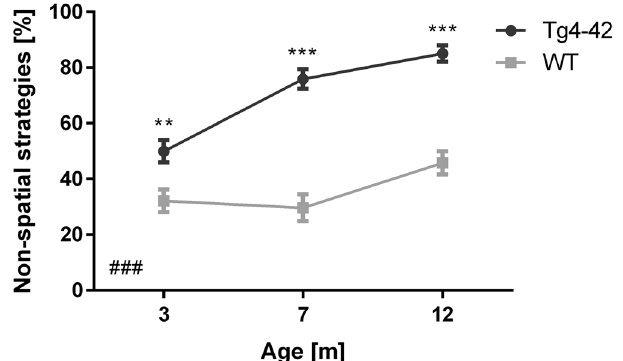
Figure 6. Tg4-42 mice use significantly more non-spatial search strategies than WT. Percentage of non-spatial search strategies for female Tg4-42 and WT mice during the acquisition training. Tg4-42 mice used significantly more non-spatial strategies than WT at any age tested. Two-way repeated measures ANOVA followed by Bonferroni multiple comparisons; n = 9–14. All Data presented as mean ± S.E.M. ANOVA: ### p < 0.001; Bonferroni: ** p < 0.01, *** p <